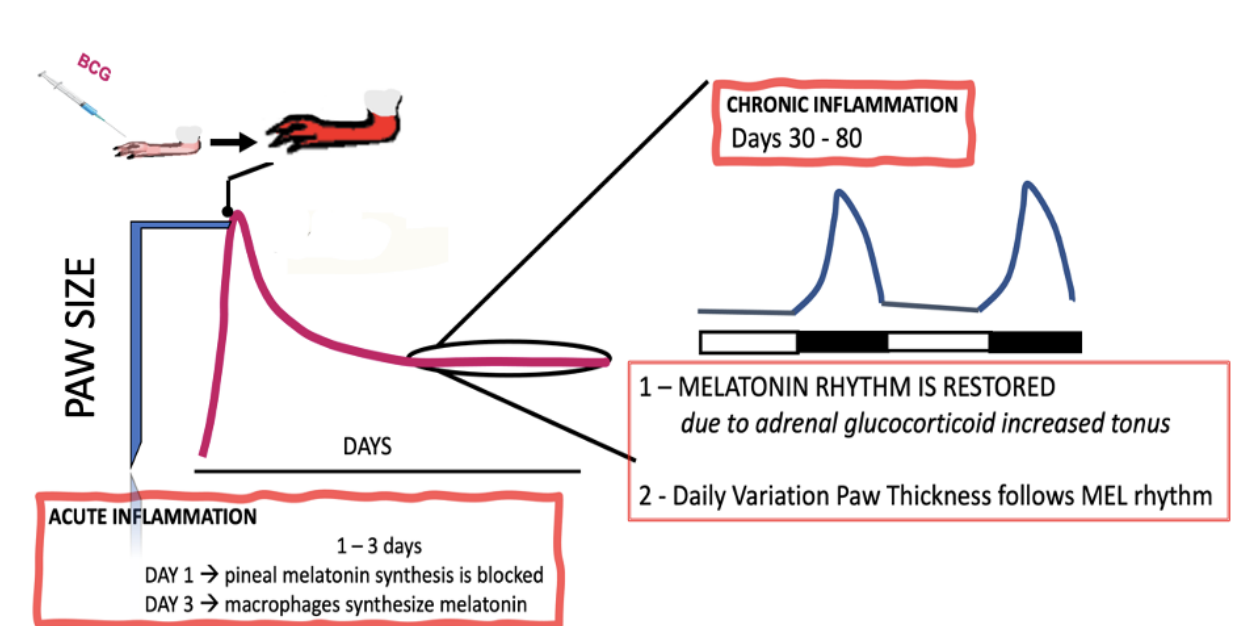
Figure 1. Pineal gland involvement over the time-course of an inflammatory response. BCG injection in a mice paw triggers an acute inflammatory response. A fast increase in the paw size due to swelling and migration of neutrophils and macrophages is followed by the formation of a granuloma. The inhibition of the pineal gland synthesis of melatonin that occurs in the first night is followed by a late recovery of nocturnal melatonin synthesis sustained by the increase in adrenal glucocorticoids. Melatonin rhythm imposes a daily rhythm in paw size [2,4,5].